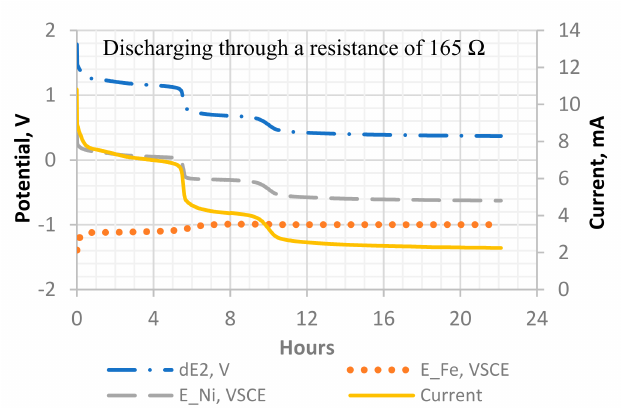
Figure 9. A detailed potential and current profile of discharge cycle 1 of the Ni-Fe cell. Measurements include the potential difference between the cathode and anode (dE2), the potential of the iron plate as anode (E_Fe, V_ SCE ), the potential of the Ni-CF cathode (E_Ni, V_ SCE ), and the current with a 165 Ω